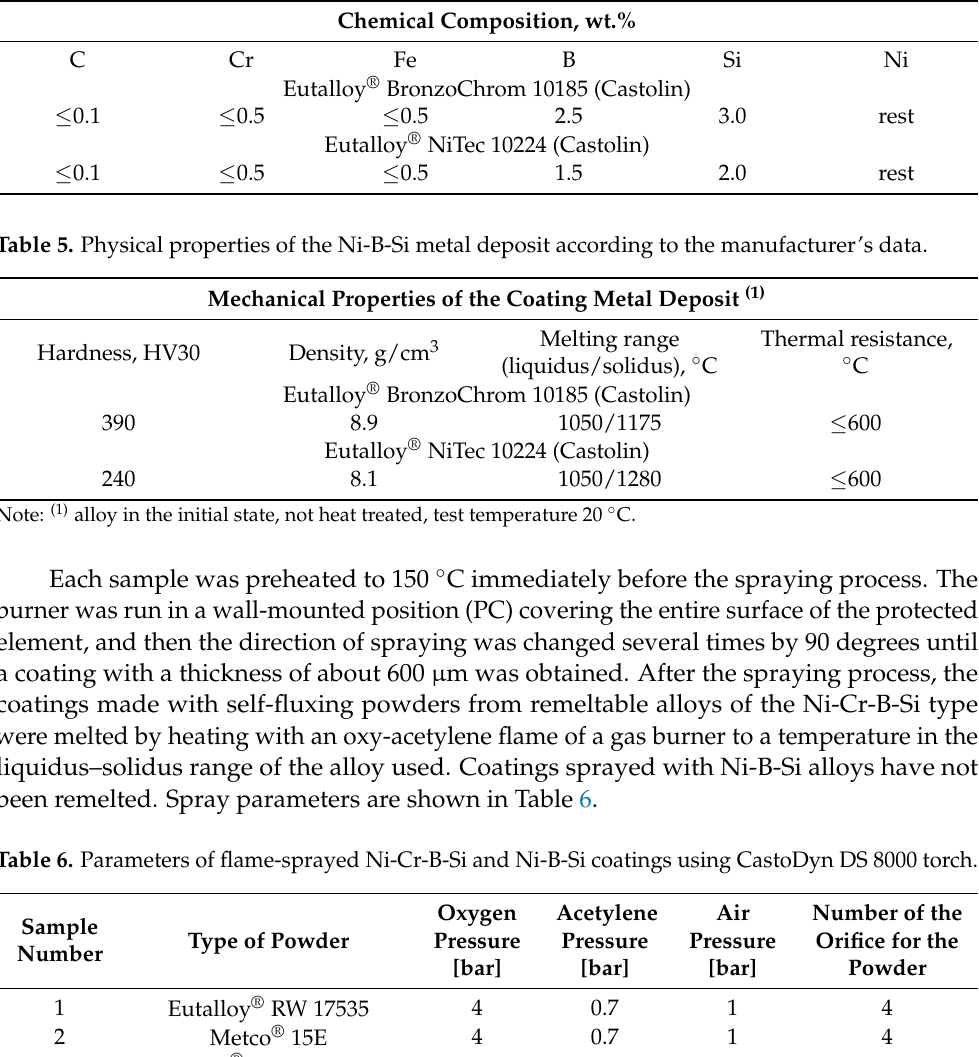
Table 4. Chemical composition of the Ni-B-Si metal deposit according to the manufacturer’s data. Chemical Composition, wt.%